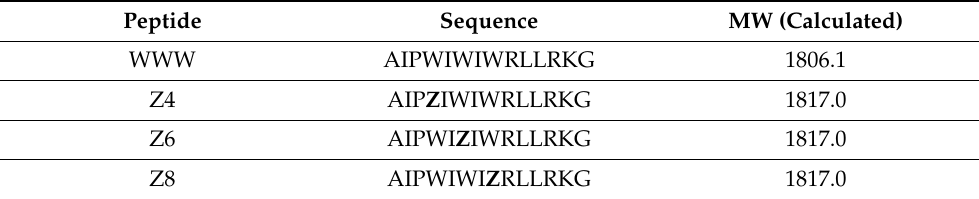
Table 1. Sequences of buCATHL-4B AzAla-derivatives used in this study (Z denotes AzAla).